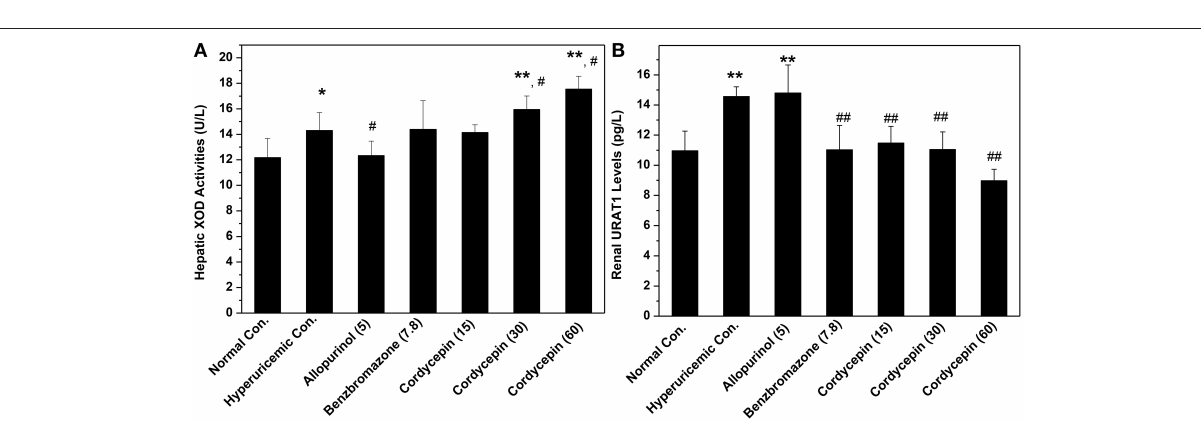
From the averaged structure ( Figure 9A ), the hydroxymethyl group on the sugar moiety and amine group on the nucleoside part of cordycepin could form HBonds to TRP200 and